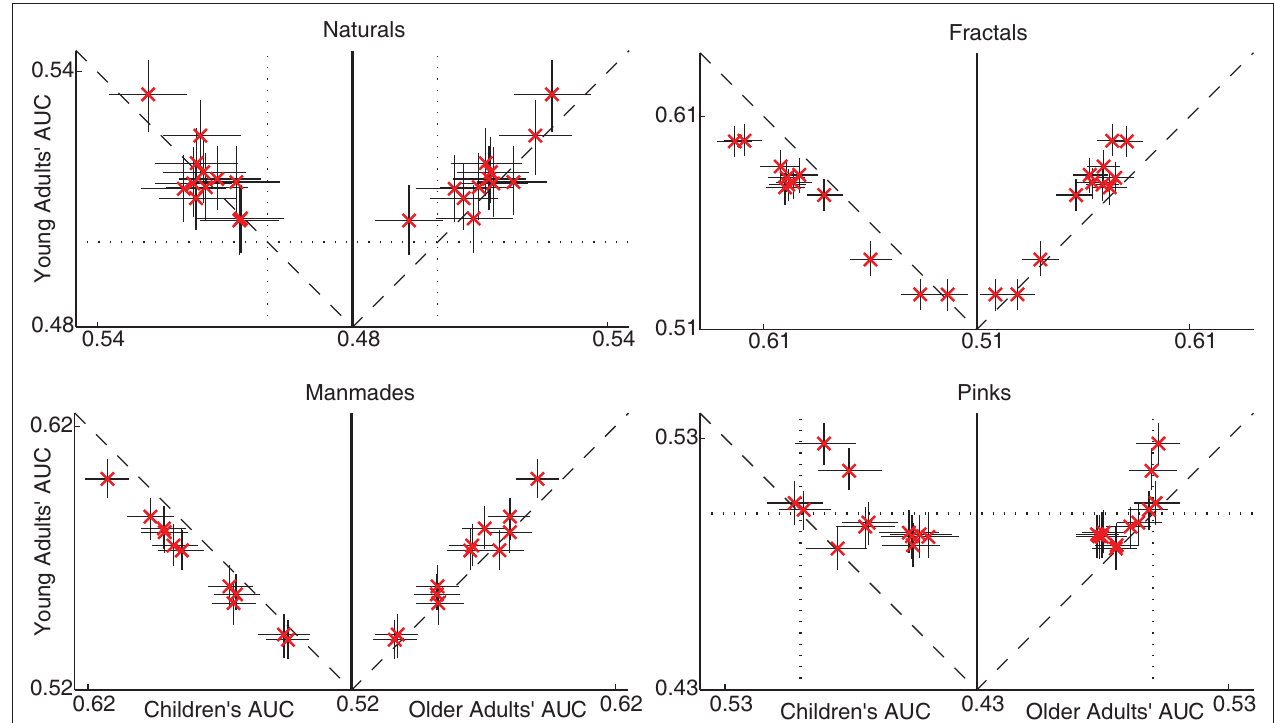
Figure 5 | Age comparison of local image feature-related viewing. In all panels, of the origin. Dashed lines denote the diagonals, and the dotted lines the AUC value each marker cross corresponds to one feature AUC (see Materials and Methods). of 0.50 (no discrimination). Note the very low and smaller than 0.50 AUC values of P The data is plotted such that young adults’ feature AUCs are compared to children’s naturals and pinks , respectively. The features used provided better discriminability AUCs on the left, and to older adults’ AUCs on the right. That is, the ordinates on the for fractals and manmades, and in those cases the AUCs decreased from children two sides of the same panel are identical and report the young adult data. Please to young adults and from them to older adults, as shown by data lying below the note that the origins are panel specific, and the x -axis is symmetric on the two sides diagonal on the left and above the diagonal on the